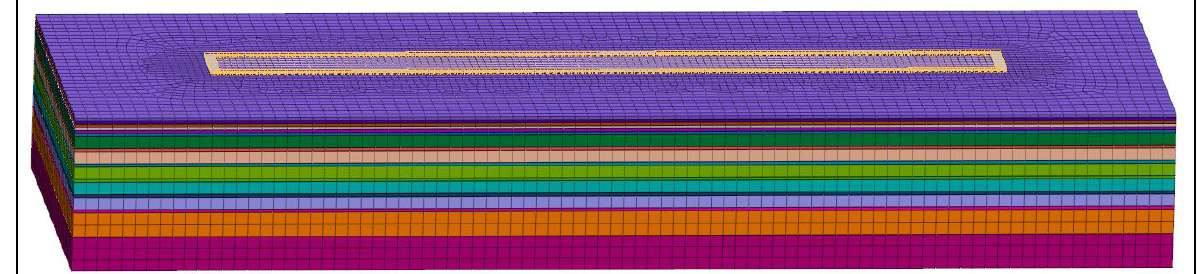
Figure 17. Midas finite element model of foundation pit.